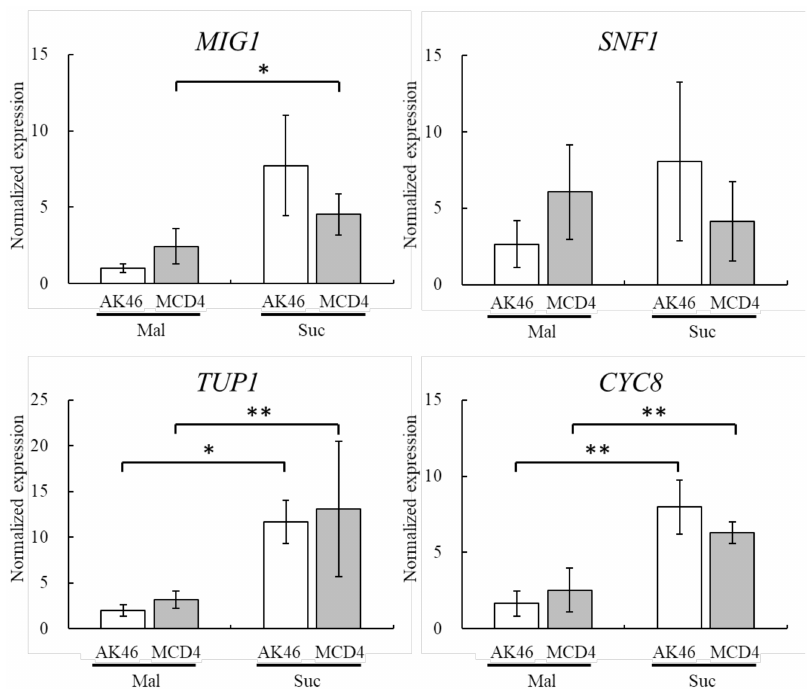
Figure 3. Relative expression of catabolite repression-related genes ( MIG1 , SNF1 , TUP1 , and CYC8 ) of S. cerevisiae AK46 and MCD4 incubated in maltose- or sucrose-medium for 1 h. The values are shown as the means ± S.D. of three replicates. * p < 0.05; ** p < 0.01 (Student’s t -test).